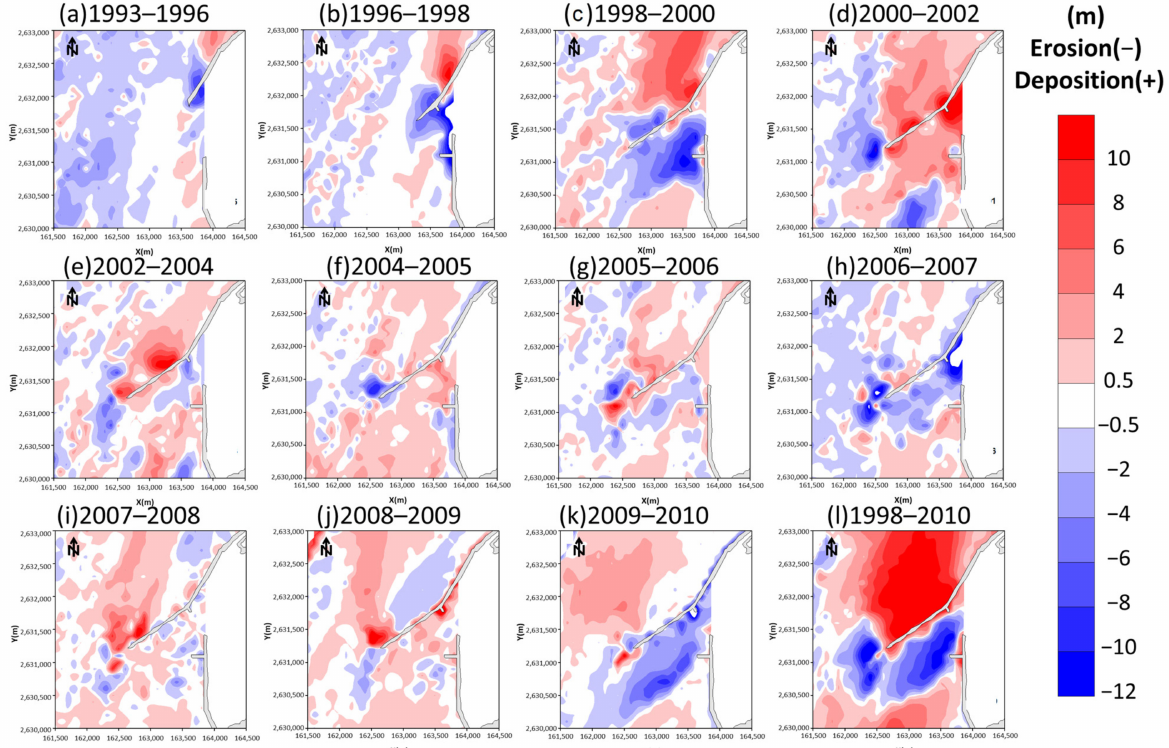
Figure 6. The topographic change near Mailiao West